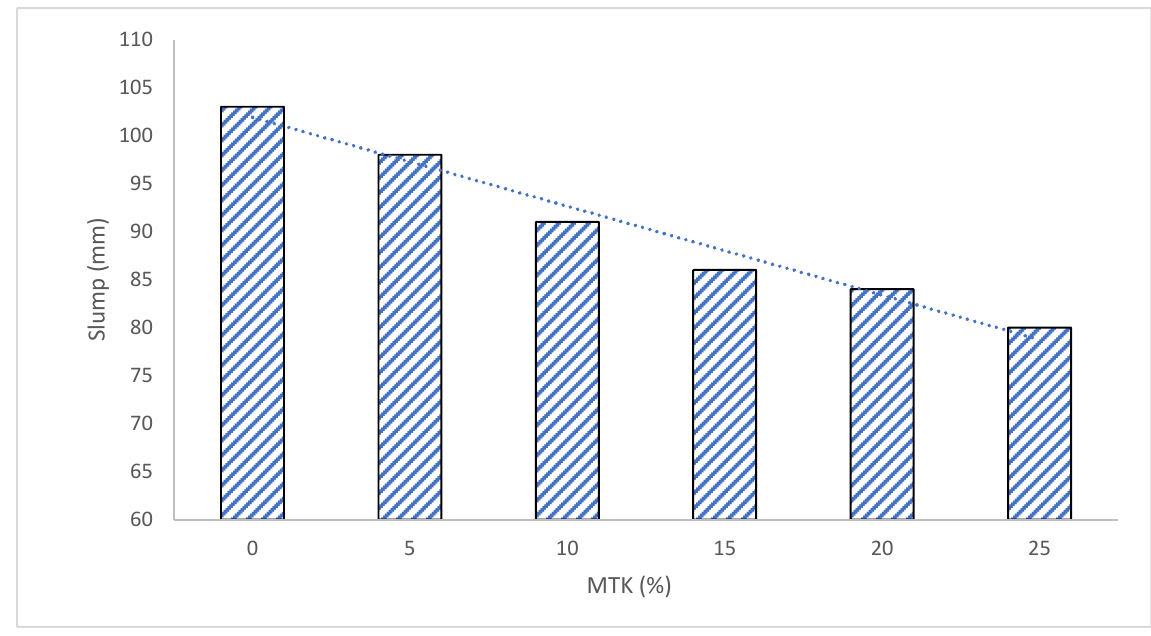
Figure 5. The slump flow of concrete with MTK [61].